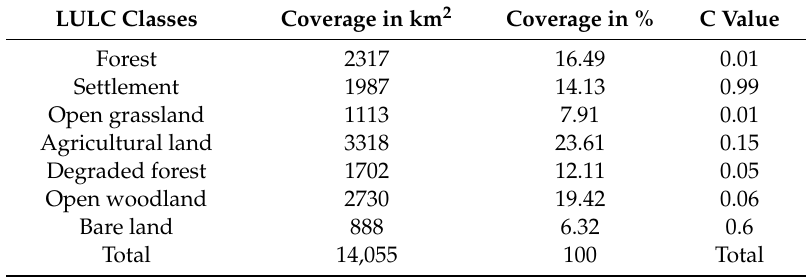
Table 3. Land use land cover (LULC) and C-factor values of the Welmel watershed.